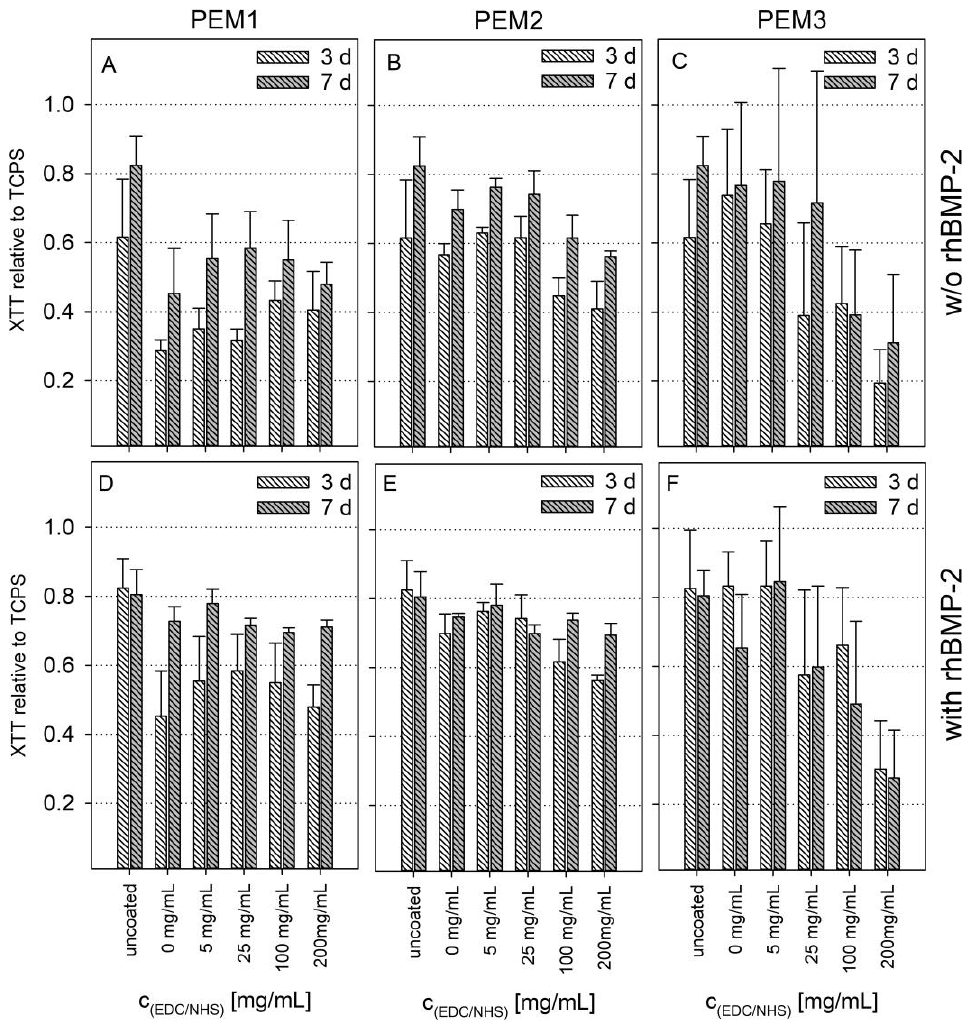
Figure 4. Absorbance in XTT assay relative to TCPS after 3 and 7 days on different cross-linked PEMs without BMP-2 ( A – C ) or loaded with BMP-2 ( D – F ). Error bars represent standard deviations of three independent experiments with three technical replicates each. Results of a one-way